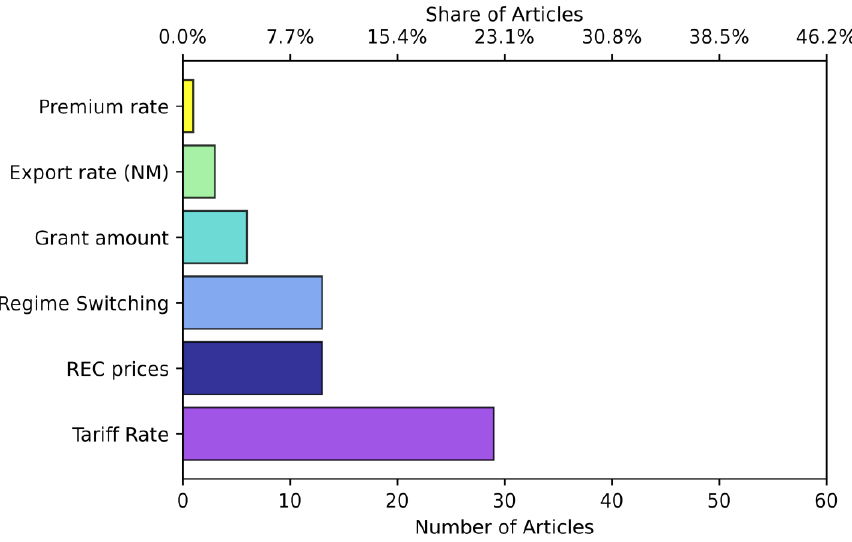
Figure 5. Number and share of articles in the pool that consider each source of subsidy uncertainty, which depends on the RF. As each article can consider more than one RF, the sum of all the SoUs considered in this graph is greater than the subsidy uncertainty in Figure